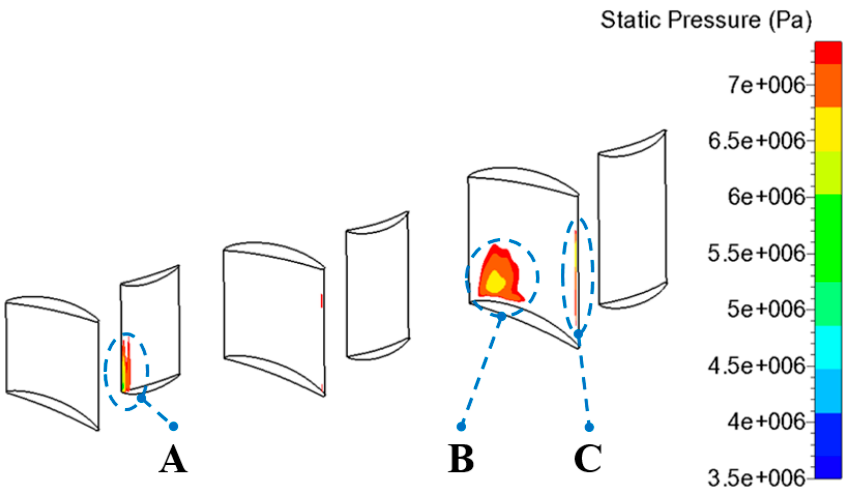
Figure 10. Sketch of transcritical region on blade surface.